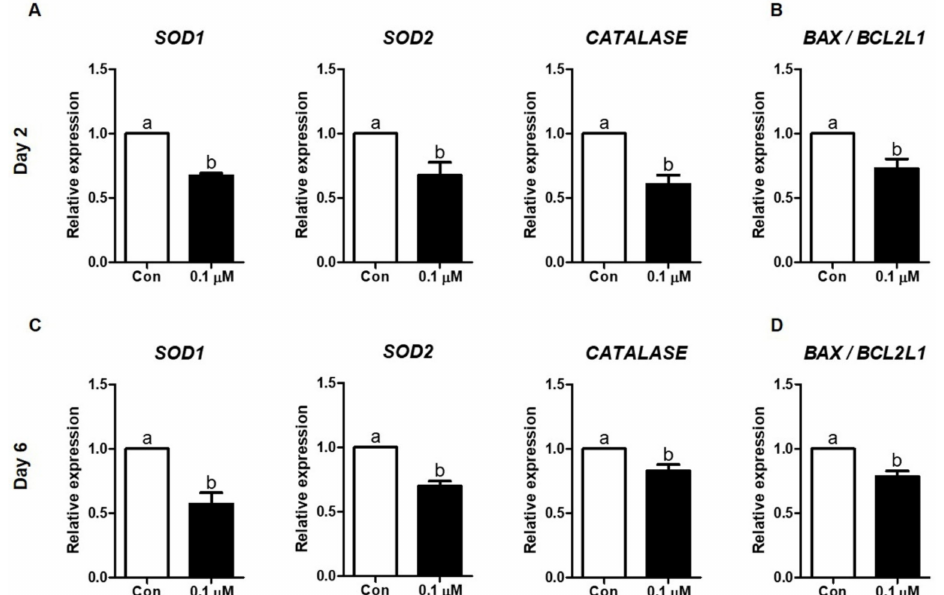
Figure 7. Effect of lycopene on expression levels of antioxidant enzymes- and apoptosis-related mRNAs in porcine IVF embryos. ( A , C ) Antioxidant enzymes-related mRNAs in Day-2 and Day-6 IVF embryos. ( B , D ) Apoptosis-related mRNAs in Day-2 and Day-6 IVF embryos. Different superscript letters (a,b) represent the significant difference ( p < 0.05). Abbreviations: IVF, in vitro fertilized; Con, control; 0.1 µ M, 0.1 µ M